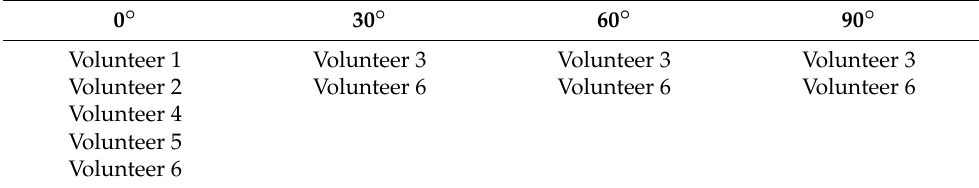
Table 1. Scans acquired at different angles of flexion for different subjects.